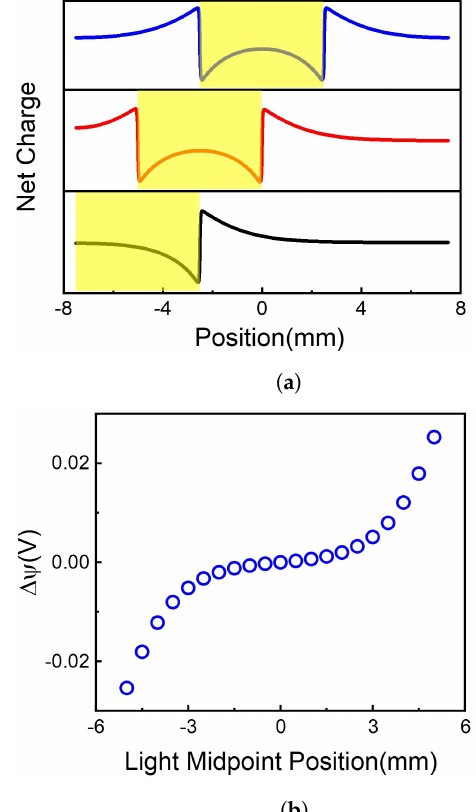
Figure 3. Net charge distribution and voltage difference along 2D membrane at different illumination center positions. ( a ) Light illumination causes the charge redistribution along the 2D membrane. ( b ) The voltage difference caused by different illumination center